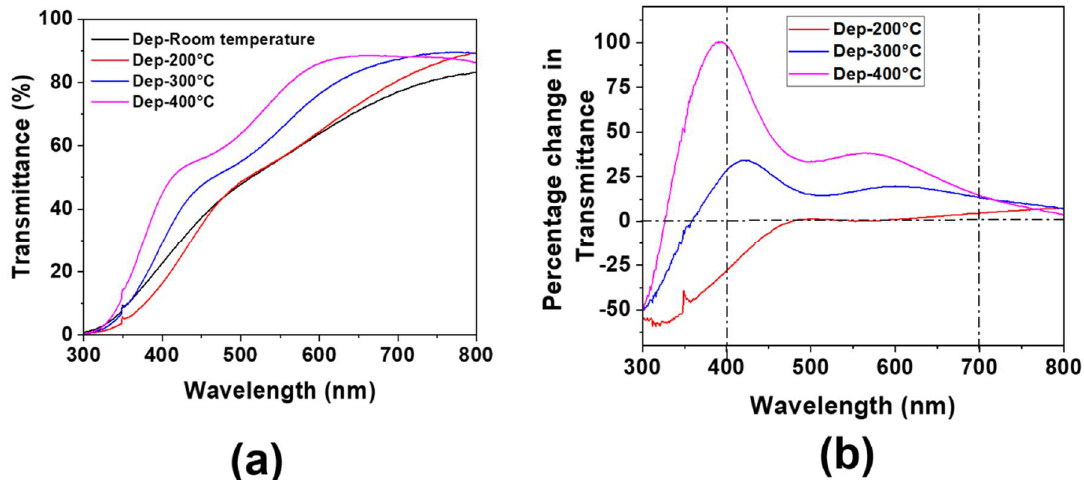
Figure 5. ( a ) Transmittance spectra of CuInO x films on quartz at different temperatures during deposition. ( b ) Percentage increase in transmittance for the deposited films due to the effect of substrate heating with respect to room temperature deposition.